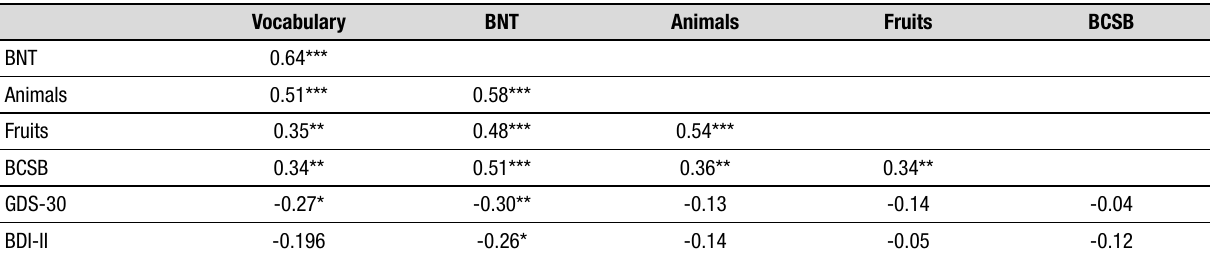
Table 4. Correlations.